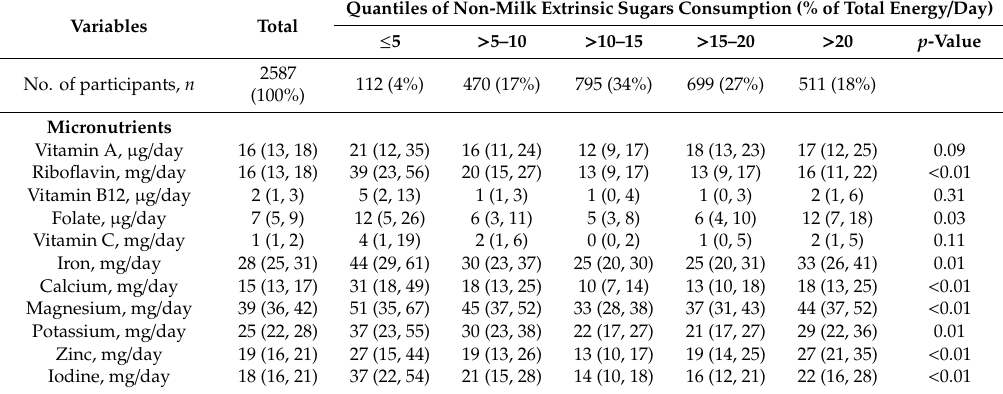
Table 4. Proportion of adolescents aged 11 to 18 years in the National Diet and Nutrition Survey with energy ( n = 2587) after the application of survey weights, expressed as percentage (99%